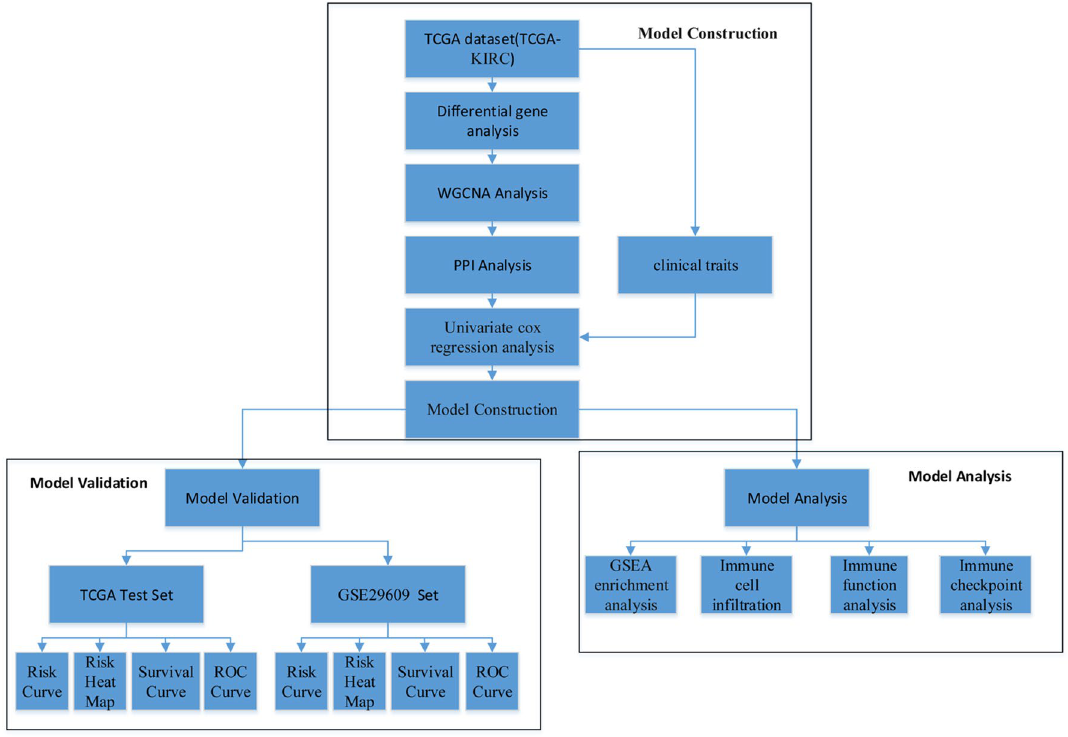
Figure 1. Design flow chart. The design includes three parts, model construction, model validation, and model